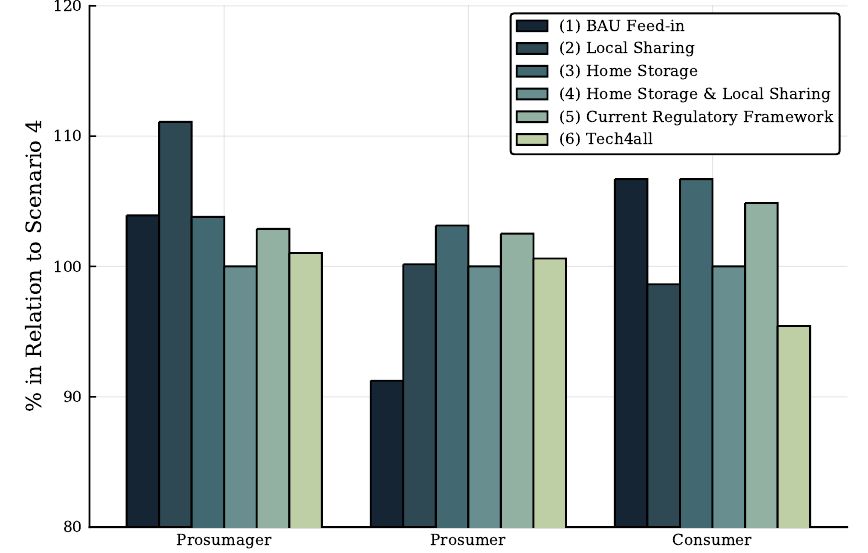
Figure 4. Comparison of costs for the simulated scenarios in percent in relation to design 4